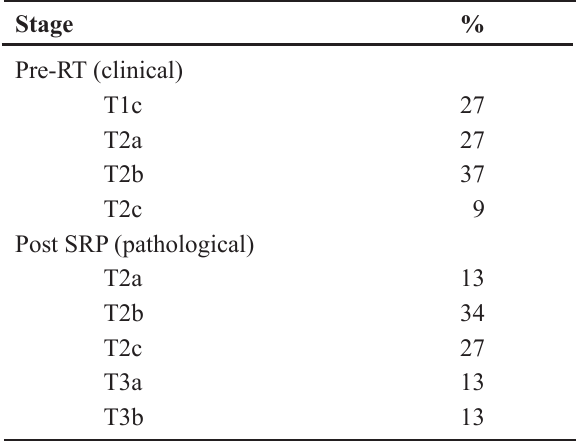
Table 2 – Pre-RT and post SRP staging (TNM - 2002) in 42 patients who underwent salvage radical prostatectomy (SRP).